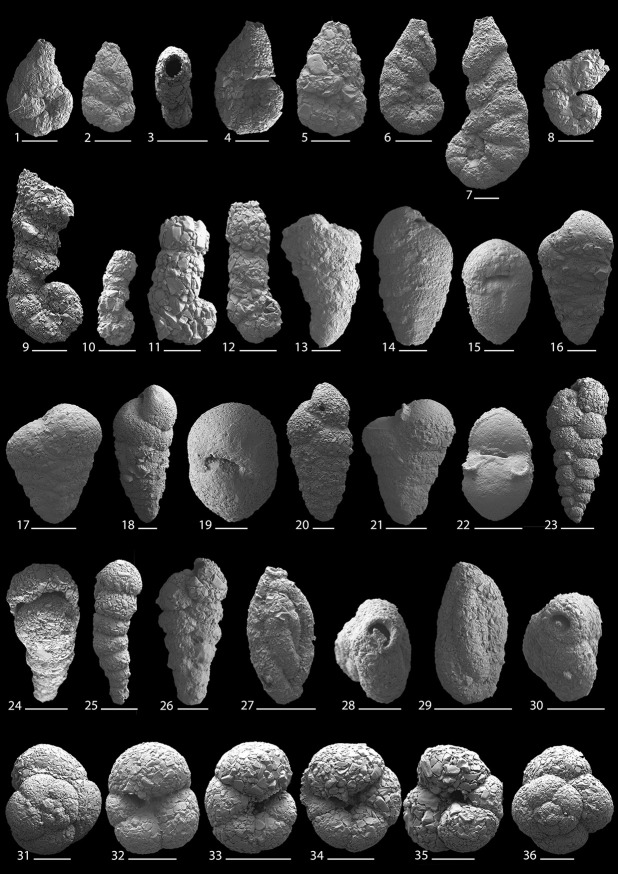
Scanning electron micrographs of benthic foraminifera from the Lagos Lagoon: 1–7.Ammotium salsum (Cushman and Brönnimann, 1948); scale bar for Fig 10.2 is 200 μm; 8, 9. Ammotium sp. 1; 10–12.
Ammobaculites exiguus Cushman and Brönnimann, 1948; 13. Textularia candeiana d’Orbigny, 1839; 14–17. Textularia sp. 1; 18–20. Textularia sp. 2; 21, 22. Siphotextularia sp. 1; 23–26. Caronia exilis (Cushman and Brönnimann, 1948); scale bar for Fig 10.26 is 50 μm; 27–30. Milliamina fusca (Brady, 1870); 30–36. Trochammina sp. 1. Scale bar is 100 μm for all magnifications.